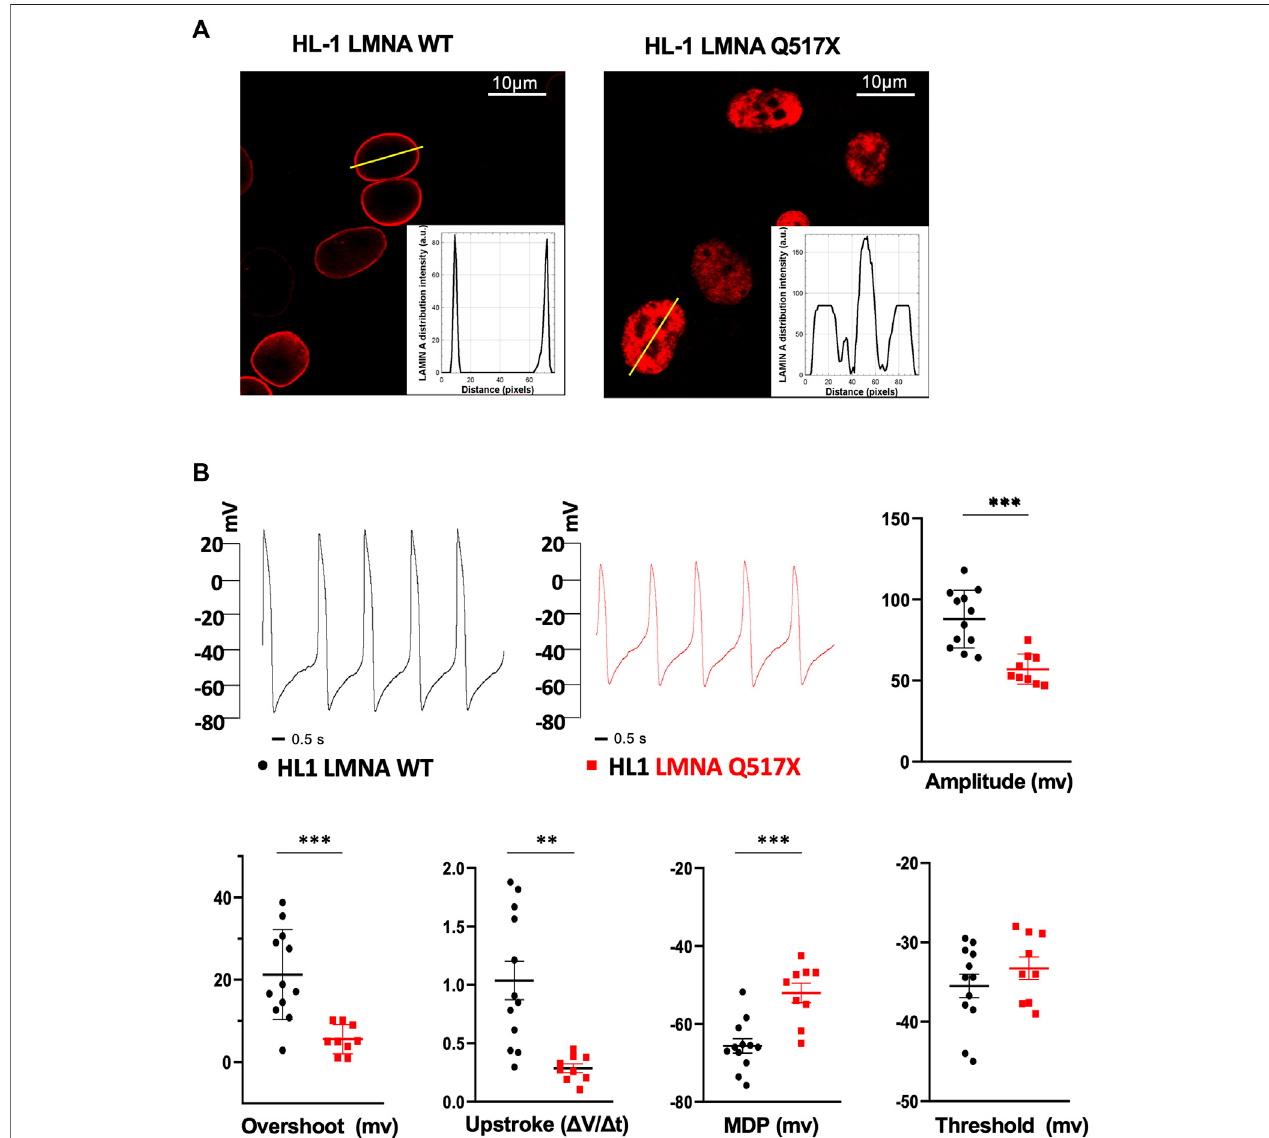
FIGURE 2 | (A) Representative confocal immuno fl uorescence images of LMNA WT and Q517X in stably transfected HL-1 cardiomyocytes. The insets report the fl uorescence distribution along the line (yellow line) crossing nuclei in each cell line. (B) Representative AP recordings by whole-cell patch clamp in the current clamp con fi guration inLMNAWT (black trace)and LMNAQ517X-expressing HL-1cells (redtrace)and scatter plotsfortheanalysisofAPparameters inLMNA WT(blackdots, N = 12) and LMNA Q517X-expressing HL-1 cells (red squares, N = 9); *** p < 0.001; ** p < 0.01; Student ’ s t-test for unpaired data.